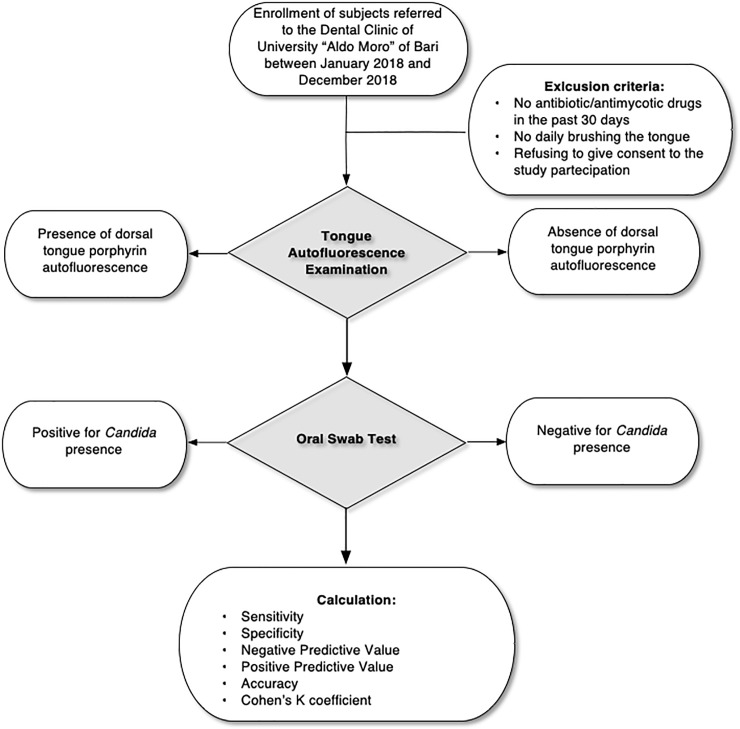
Flow-chart.Study protocol flow-chart.